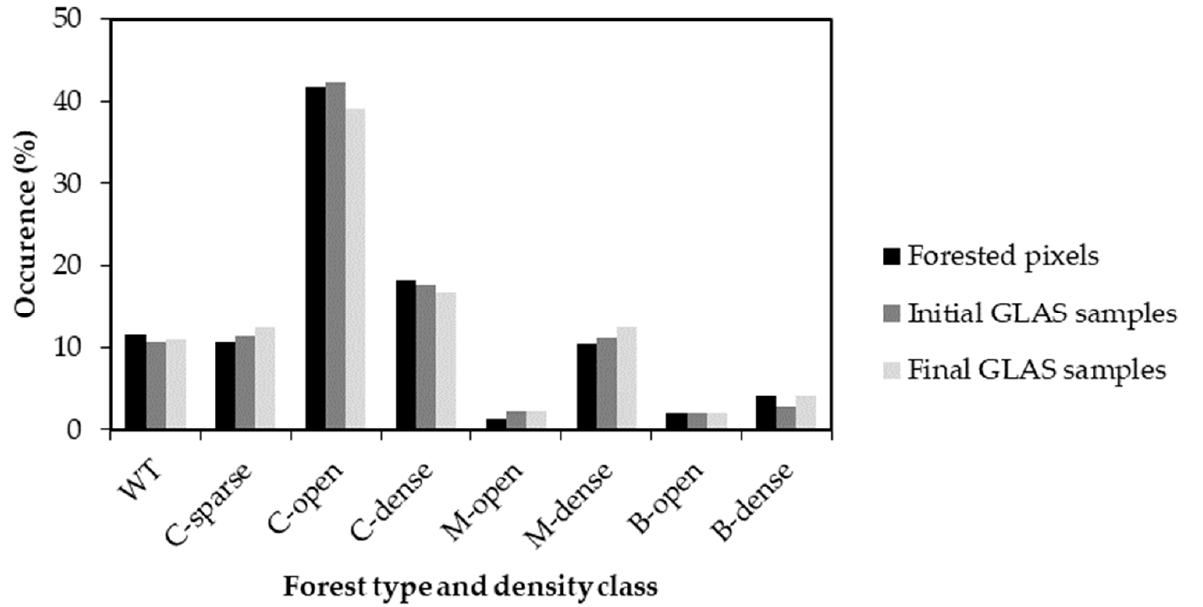
Figure 2. Percent occurrence of forest cover types (WT: wetland treed; C: conifer; M: mixedwood; B: